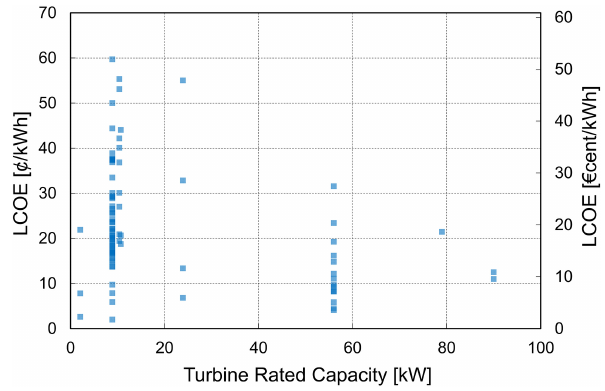
Figure 7. The 3-year-average capacity factor for several US wind projects. Data from Orrell et al. (2020).